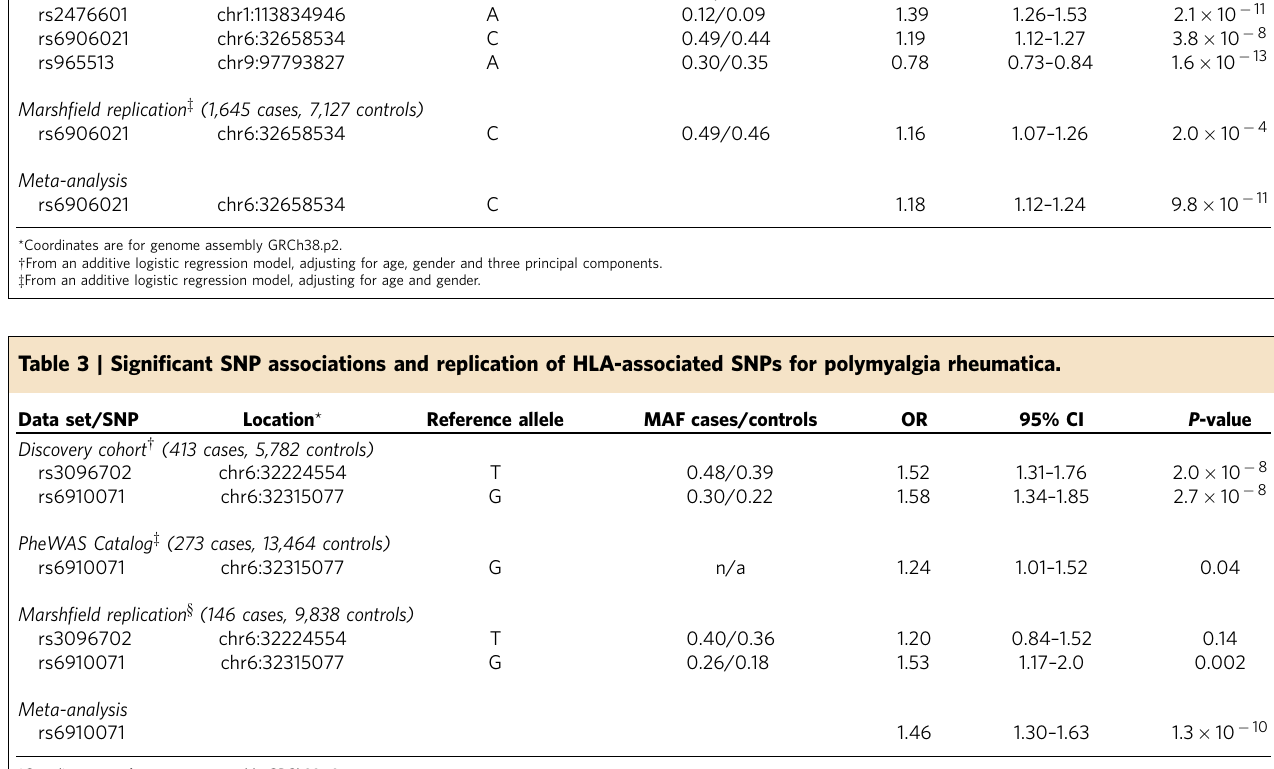
*Coordinates are for genome assembly GRCh38.p2. w From an additive logistic regression model, adjusting for age, gender and three principal components (PCs). z Results extracted from the PheWAS Catalog for an additive logistic regression model, adjusting for age, gender and three PCs. y From an additive logistic regression model, adjusting for age and